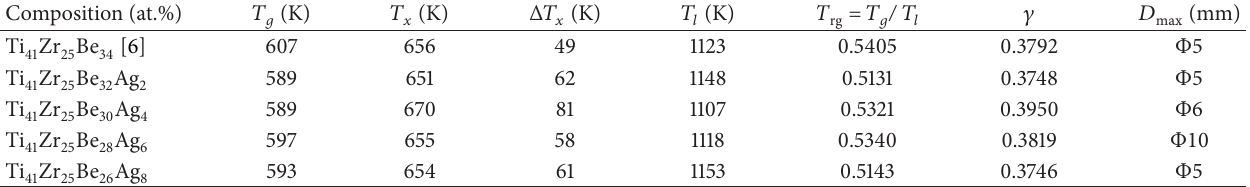
Zr Be 34−𝑥 Ag 𝑥 ( 𝑥 = 2 , 4, 6, 8 at.%) BMGs. The error of the temperature values is ± 1K. 41 25